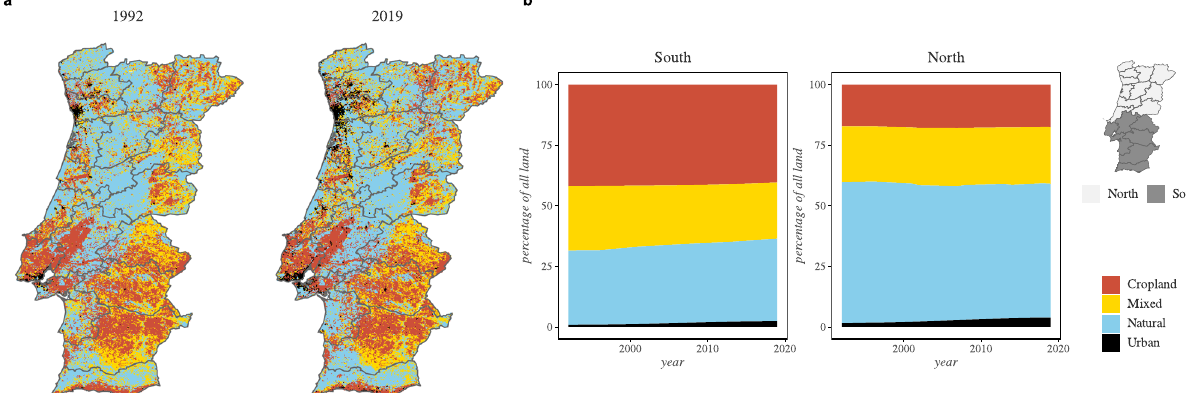
Fig. 3 Land types in Portugal (1992 – 2019). a Shows the spatial distribution of different land types for the years 1992 (left) and 2019 (right). b is the percentage of land types over time for the south (left) and north (right) regions. In all panels, colours for land types are shown on the right. The North-South divide is the same as de fi ned in the legend of Fig. 1 (boundaries shown on the map to the right).